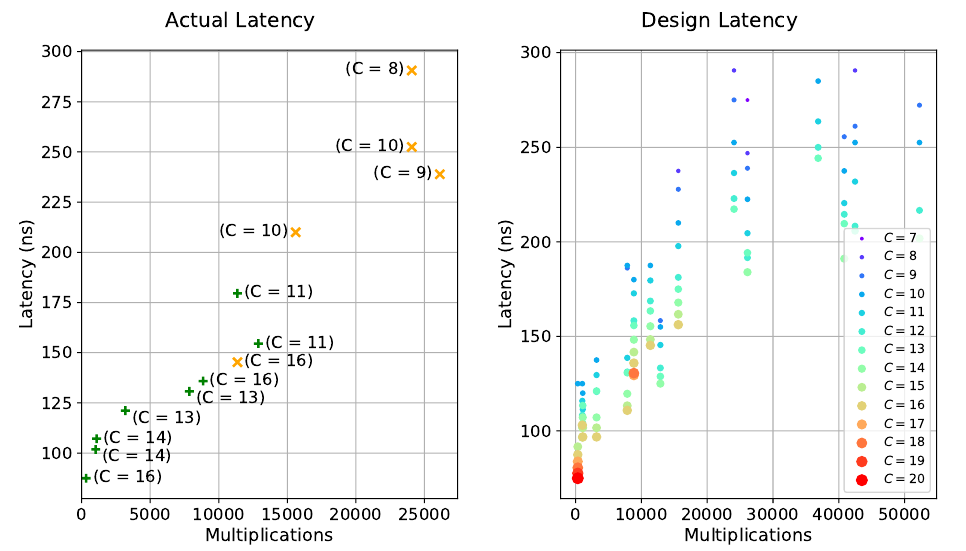
Figure 5. The achieved latencies for some of the networks are shown on the left. Networks which reached timing closure are indicated with a green cross while the ones that failed by a small fraction are shown as yellow cross. The values for the ratio between the processing and the data frequency, C , of the individual networks are indicated in brackets. Under the assumption that timing closure can be achieved, the right plot shows the network latency depending on C where each column represents one example network.